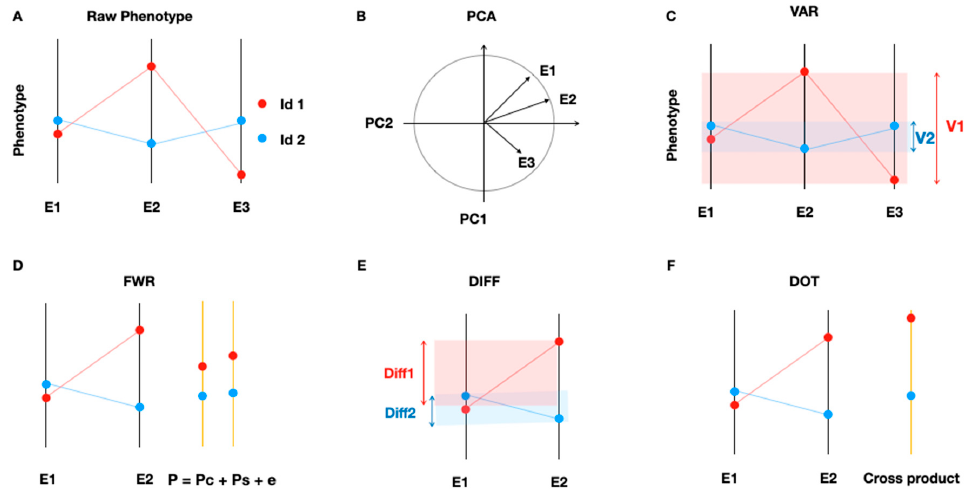
Figure 1. Schematic illustrations of the five approaches evaluated to quantify the phenotype plasticity. ( A ) Illustration of the concept of phenotypic plasticity. Each bar represents an environment and the average phenotype of two haploid segregants (genotypes, id1 and id2) are illustrated using red/blue dots. Average growths for the segregants (horizontal blue and red lines) vary across three environments (vertical black lines). The growth for one segregant (red) varies more (is more plastic) in response to the environment than the other (blue). Three measures of overall phenotype (growth) plasticity across all environments (growth media) are used and schematically illustrated in ( B – D ). The first, PCA , uses a principle component analysis of a matrix containing growth measures of segregants in all media. ( B ) A variable loading plot showing the contributions by the growth in three media (environments) to the first two principal components (PC1 and PC2). The two PCs explaining the most variance are used as measures of plasticity (abbreviated PCA1 and PCA2 ). The second overall measure ( VAR, ( C )) quantifies plasticity as the across environment variance of individual segregant growth. The third overall measurement ( FWR , ( D )) partitions growth into two components, one ( Pc ) that is constant across environments and another (Ps) that varies across environments. Here, growths (phenotypes) measured on two media (environments, E1 and E2) are illustrated on the left, resulting in a hypothetical partitioning in the two components on the right. Two specific growth plasticity measures for each of the pairs of media (environments) are used. ( E ) DIFF that is quantified as the pairwise growth difference, and ( F ) DOT quantified as the cross product of standardized growth measurements between paired media (environments, E1 and E2).